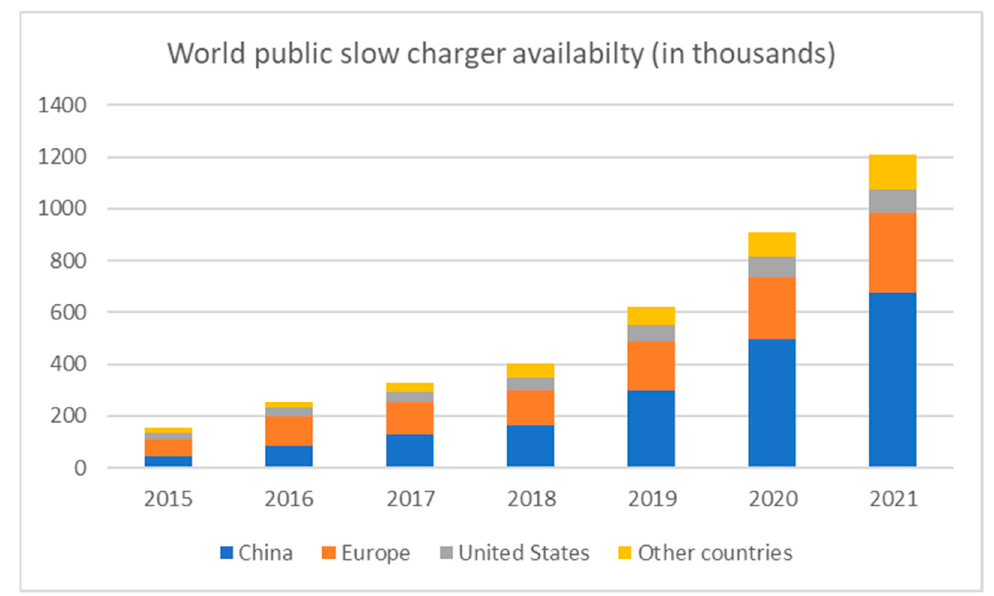
Figure 6. Publicly available slow charger availability in recent years [27].